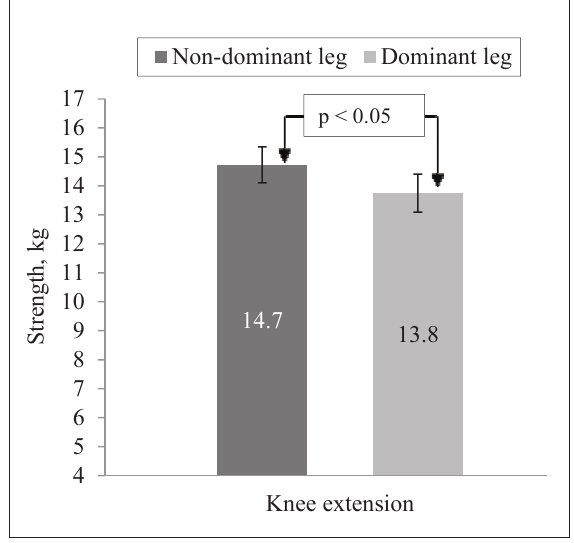
Figure 2. Change in the strength (kg) of muscles of the dominant and non-dominant leg after the knee extension